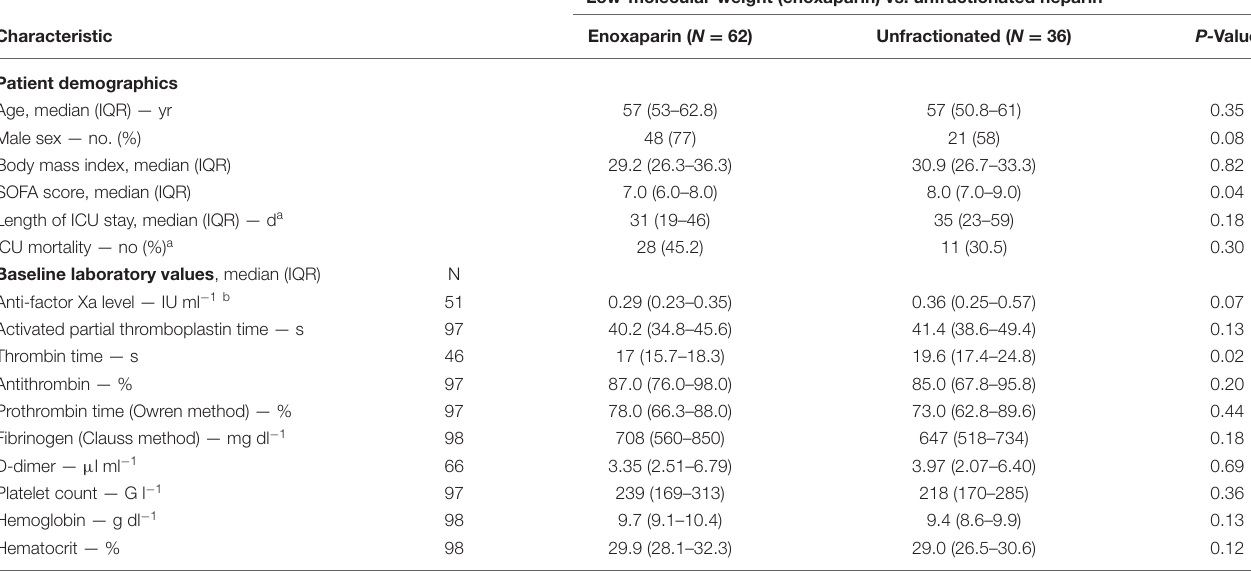
Low-molecular-weight (enoxaparin) vs. unfractionated